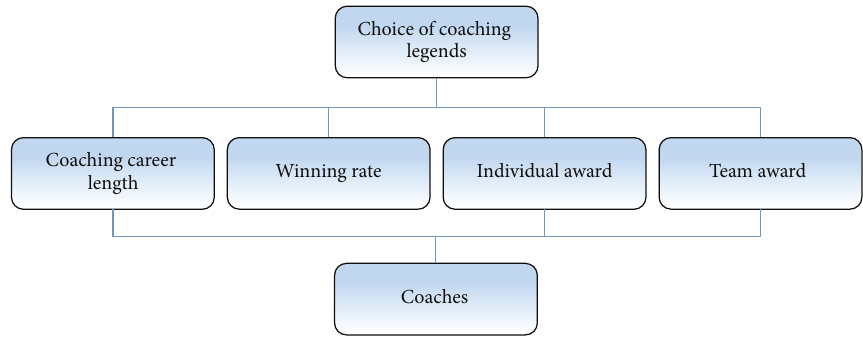
Figure 1: General graph model.